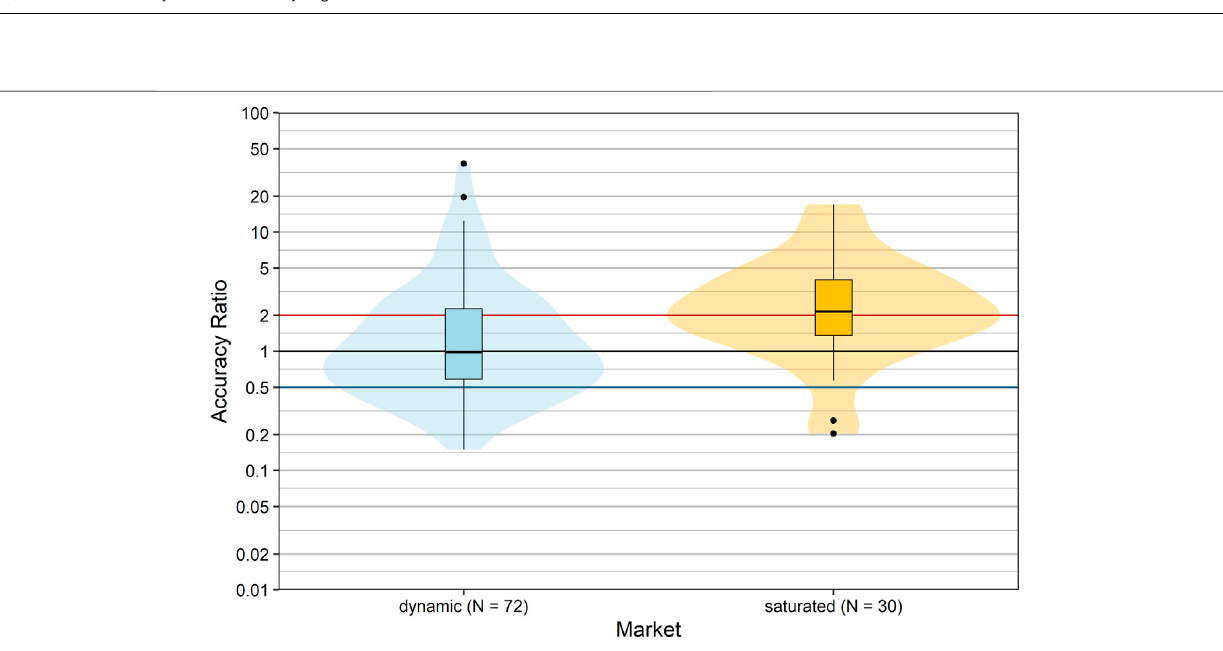
FIGURE 4 | Comparison of accuracy ratios by market dynamics. Box plots and violin plots show accuracy ratios of forecasted sales in the 3 years after a positive reimbursement decision grouped according to market situation. Due to their asymmetric nature, accuracy ratios are plotted on a logarithmic (base 10) scale to avoid visually overemphasizing overestimates compared to